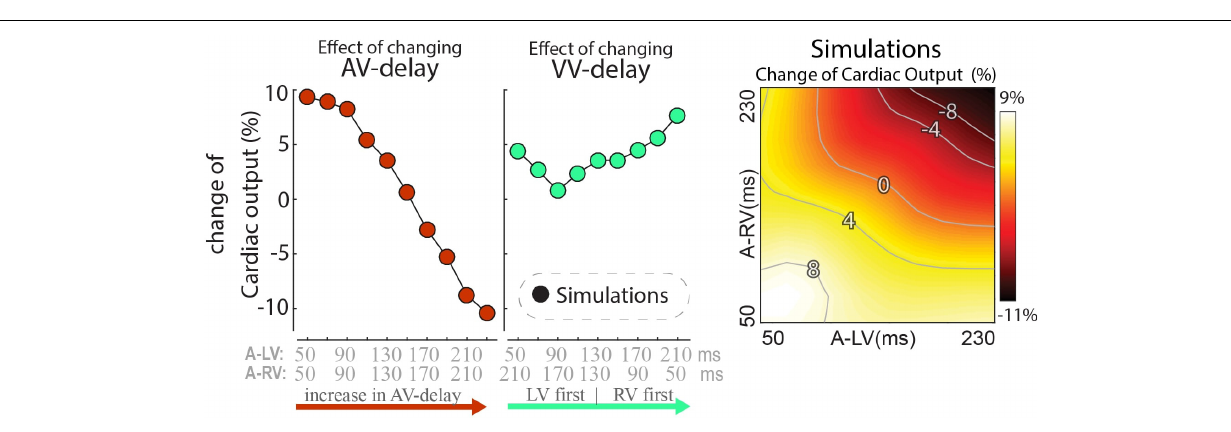
FIGURE 5 | Relative change in simulated steady-state cardiac output with a change in pacing delay settings. Depicted are the changes relative to baseline (see